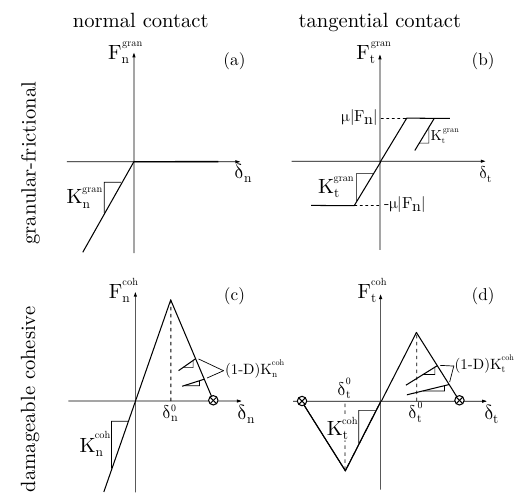
Figure 2. Normal and tangential action of the granular-frictional and cohesive contact